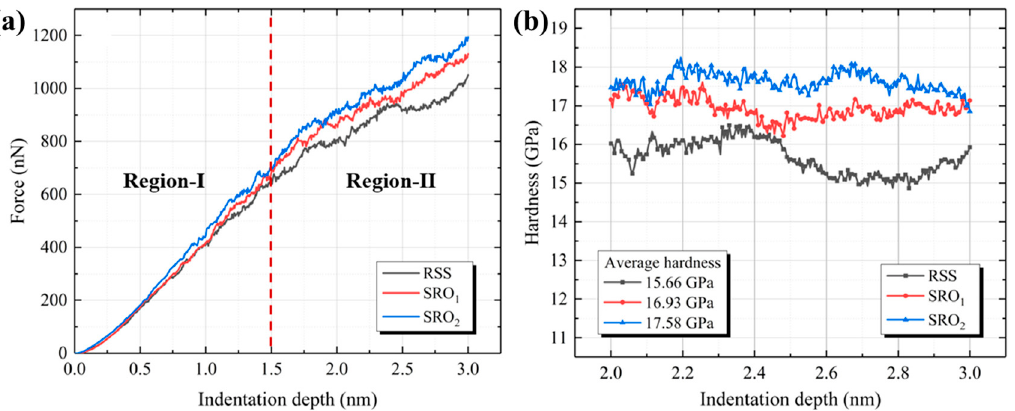
Figure 4. Effect of CSRO on the hardness of alloys. ( a ) Force–indentation depth and ( b ) hardness– indentation depth curves for different structure models (Reprinted with permission from Ref. [73]. Copyright 2022, Elsevier).